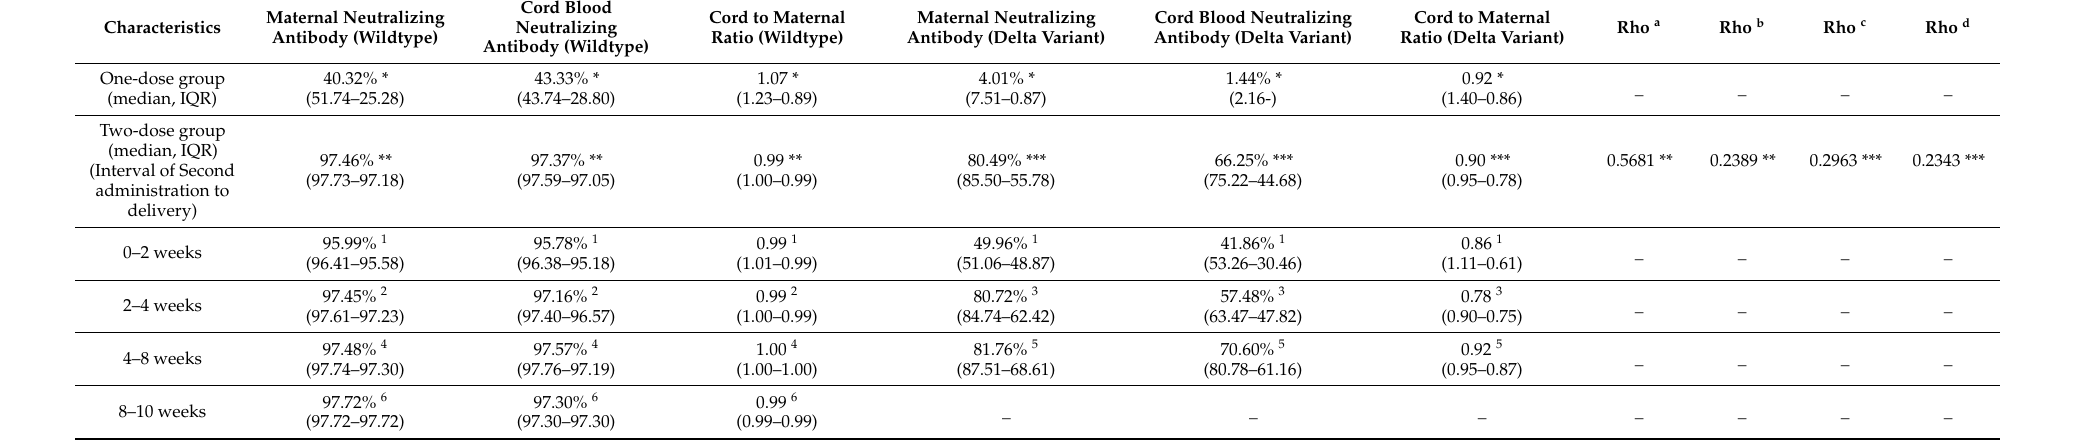
Table 2. Summary of neutralizing antibodies (wildtype and Delta variant) in maternal and cord